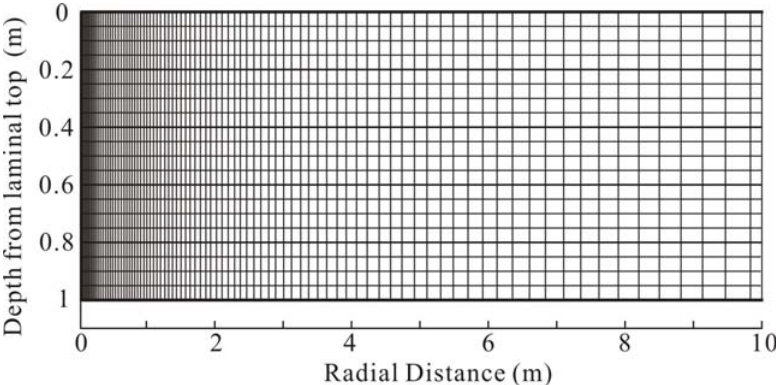
Figure 11. Grid structure of the idealized homogeneous lamina containing